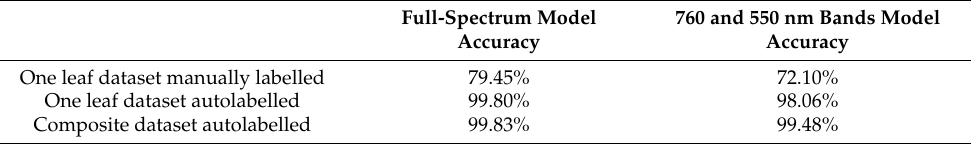
Figure 9. Comparison of the performance of the manually labelled model with the automatically labelled model with the red, green, and blue (RGB) representation of the hyperspectral image. ( A ) to ( F ) represent the classification results of the models trained on six different training sets with variations between them in the number of features used, with two features ( A – C ) compared with the full spectrum ( D – F ), the training set being an automatically labelled training set based on a region of interest of one measurement day ( B , E ) or on a region of interest of a composite image spanning the duration of the experiment ( C , F ) or based on a manually labelled training set ( A , D ). Model accuracies: 72.10% ( A ), 98.06% ( B ), 99.48% ( C ), 79.45% ( D ), 99.80% ( E ), and 99.83% ( F ). The color bar represents the label given by the automatic labelling algorithm. Table 1. Model accuracies for each of the six tested models calculated on a 70/30 split for model training and validation, respectively. The full-spectrum models incorporated all 174 wavebands retained after cutting the noisy part of the spectrum (keeping the wavebands between 450 and 920 nm). The two-feature models incorporated only two wavebands: 760 and 550 nm. These models were both trained on each of three datasets: a dataset from a single ROI spanning one leaf that showed healthy and diseased tissues (one leaf dataset) that was either manually labelled or automatically labelled using the automatic labelling algorithm and a dataset from a composite image that combined several ROIs over the entire experiment